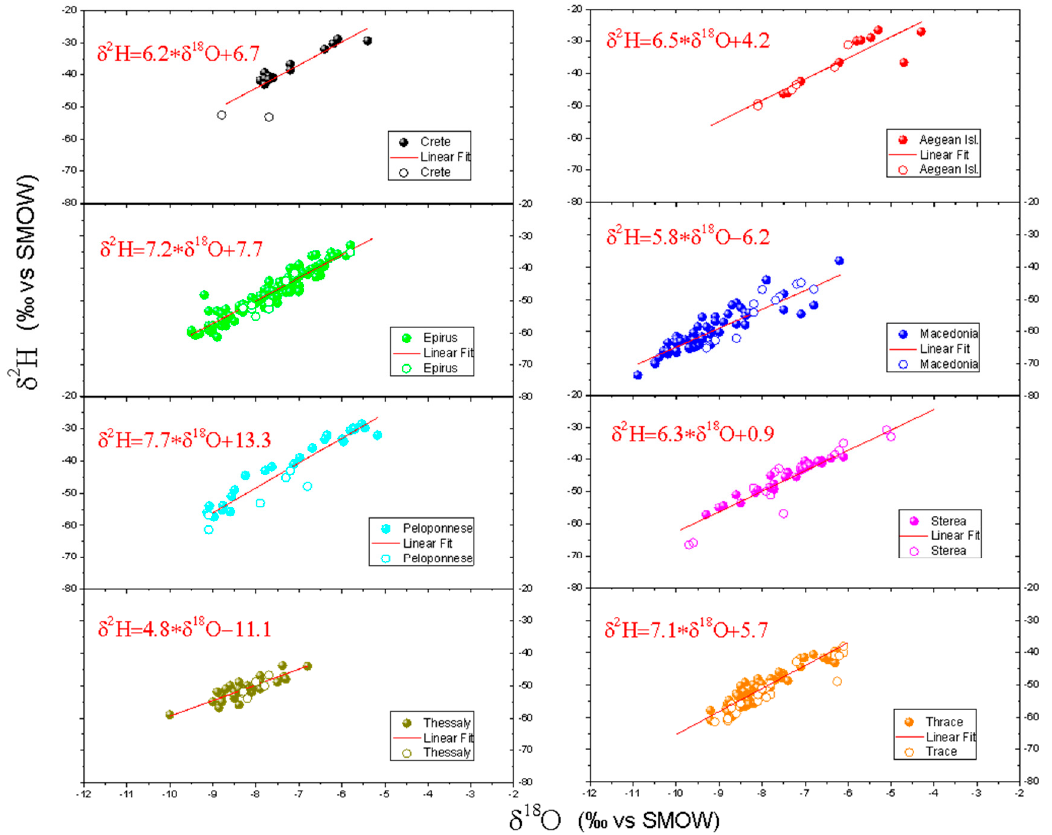
Figure 4. Local spring water lines (LSWLs) of various regions of Greece. The solid circles are bibliography data, while the hollow circles are unpublished data from this work.